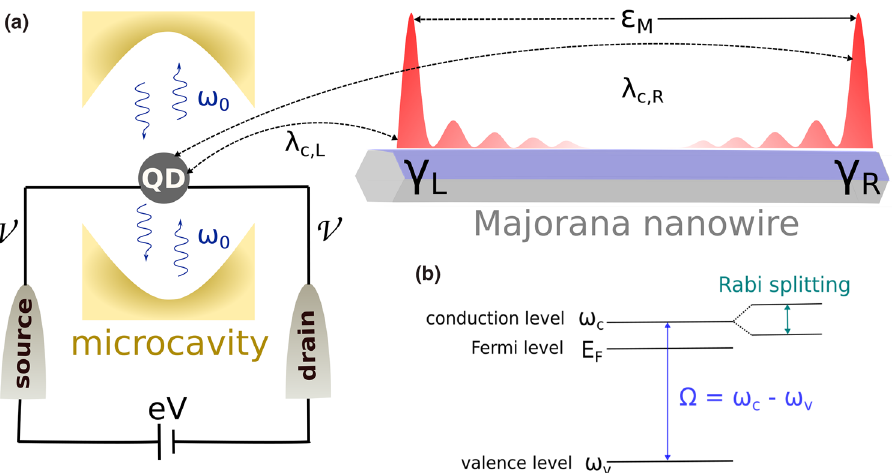
Figure 1. ( a ) The sketch of the considered system: A quantum dot (QD) embedded inside a single-mode optical cavity with frequency ω 0 . An electron in the conduction level of the dot couples with both the left ( γ R ) and the right ( γ L ) Majorana zero-modes (MZMs) located at the opposite ends of the Majorana nanowire, with strengths (cid:31) (cid:31) c , L and c , R , respectively. The overlap between the wavefunctions of MZMs is given by ε M . The tunneling conductance through the QD can by probed by means of source and drain metallic leads symmetrically coupled ( V ) to the dot. The energy of the cavity photons is brought in resonance with interband transition in the dot (cid:31) . ( b ) The scheme of a QD energy levels: the valence level ω v is far below the Fermi level E F = 0 E while the conduction level ω c is above E F . Strong coupling with cavity photons results in a Rabi splitting of the levels (cid:31) R , which is determined by the oscillator strength of the optical transition and the geometry of the